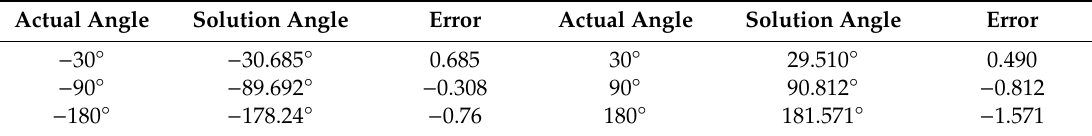
Table 5. Heading measurement record